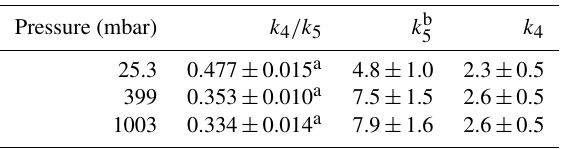
Figure 4. Depletion of C 2 H 4 (band centred at ∼ 950cm − 1 ) and C 3 O 2 (band centred at ∼ 2260cm − 1 ) during the reaction with OH. The black line ( t = 0) is the spectrum obtained before photolysis, the red, blue and purple spectra were obtained after total photolysis periods of 2, 6 and 8min, respectively. Table 1. Experimental values of k 4 / k 5 , and absolute rate constants (10 − 12 cm 3 molecule − 1 s − 1 ) .